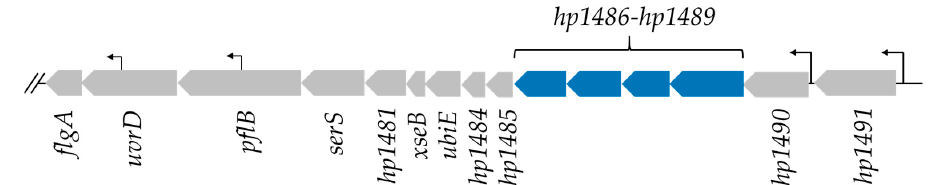
Figure 1. H. pylori 26695 operon that contains genes encoding the HP1486-HP1489 tripartite efflux system. Only the first 15 genes of the potential operon are shown. The larger arrows indicated the predicted open reading frames and are drawn approximately to scale. hp1489 , hp1488 , hp1487 , and hp1486 are indicated in blue. The operon includes two flagellar genes, flgA (encodes chaperone for the P ring protein) and pflB (paralyzed flagella protein B). Other genes of known function are uvrD (encodes DNA helicase II), serS (encodes seryl-tRNA synthetase), xseB (encodes exodeoxyribonuclease VII small subunit), and ubiE (encodes demethylmenaquinone methyltransferase). The remaining genes encode proteins of unknown function, although hp1491 is predicted to encode a phosphate transporter. The smaller arrows indicate identified transcriptional start sites that were identified from the H. pylori 26695 transcriptome [46].